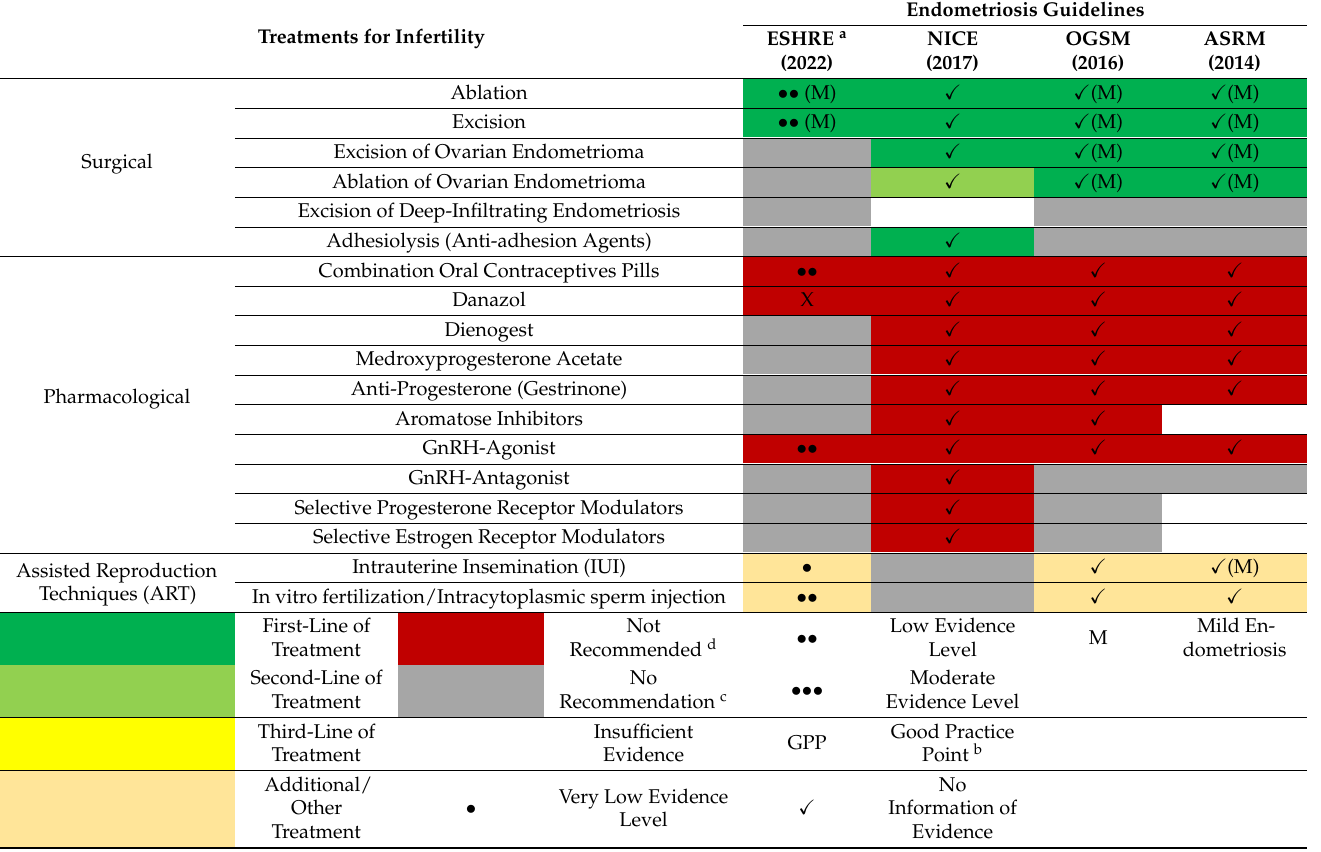
Table 2. Examples of Endometriosis Guidelines and its level of evidence in treating infertility [56,58,77,78].